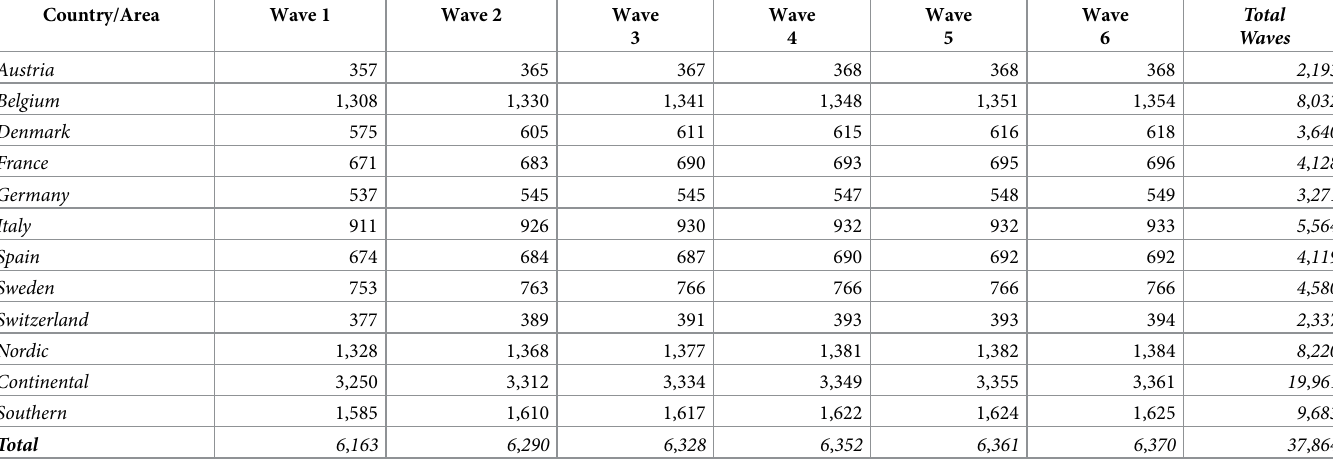
Table 1. Distribution of the analytical sample by country and geographic macro-areas (all countries (9); sample size (n) = 37,864).